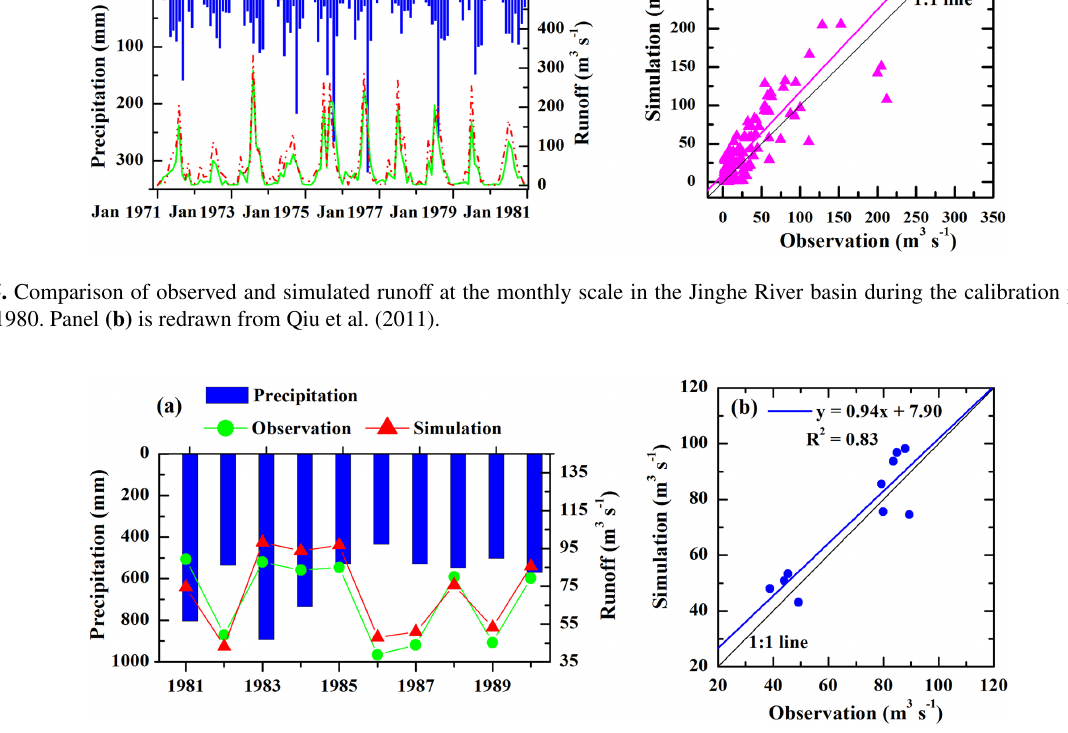
Figure 6. Comparison of observed and simulated runoff at the yearly scale in the Jinghe River basin during the validation from 1981 to 1990. Panel (b) is redrawn from Qiu et al.